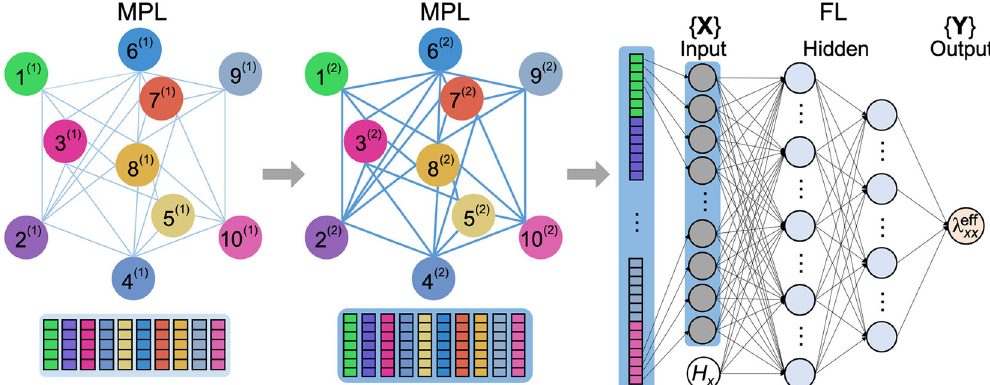
Fig. 3 Network architecture of the GNN model. A series of message passing layers (MPLs) are employed for obtaining an embedding { X } of the graph input by sequentially updating the feature matrix (sketched in the bottom). The fi rst MPL allows a speci fi c node to take messages from its neighbors. By using more MPLs, interactions between non-neighboring nodes can also be established. For example, grain #1 and #10 are interacting through intermediate grain #8. Such message-passing enables considering the in fl uence of all the other nodes in the graph on a speci fi c node, which in effect describes the magnetostatic interaction among different grains. A simple graph input with 10 nodes (grains) is used for illustration. The embedding { X }, together with the applied magnetic fi eld H x , is linked to the effective magnetostriction λ eff fully connected layer (FL).